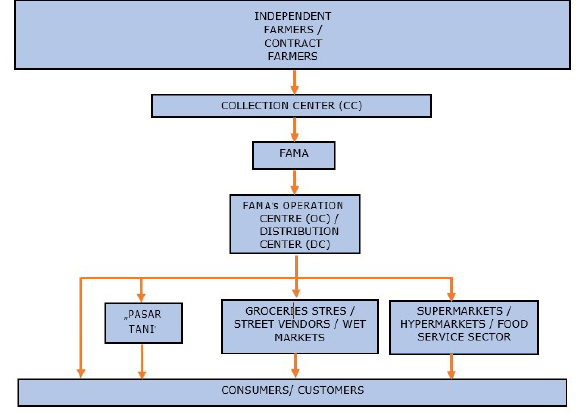
Fig. 1. FAMA’s supply chain system in